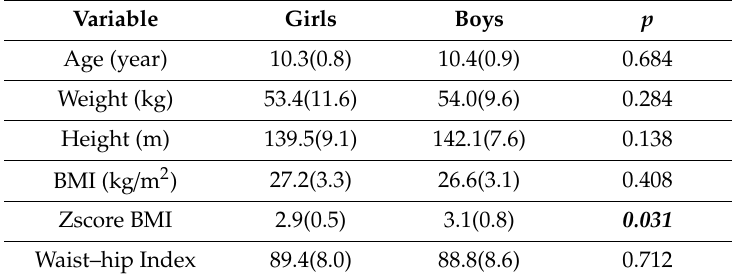
Table 2. Age and anthropometric characteristics of girls and boys in the sample (Mean and